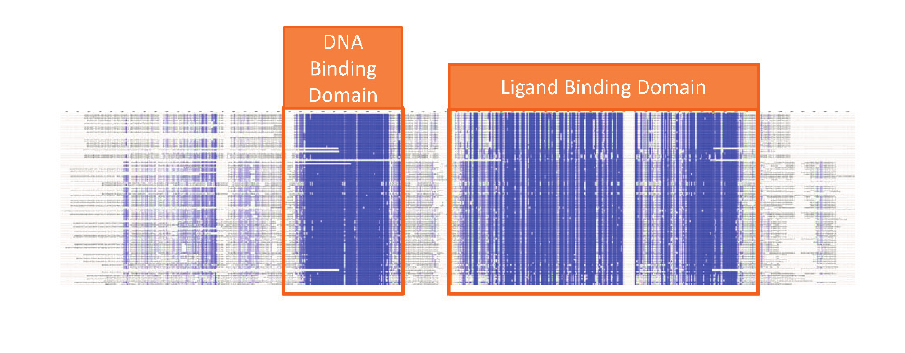
Figure 3. Sequence alignment of ER protein from different species. Blue color indicates conserved residues. The DNA binding and ligand binding domains are